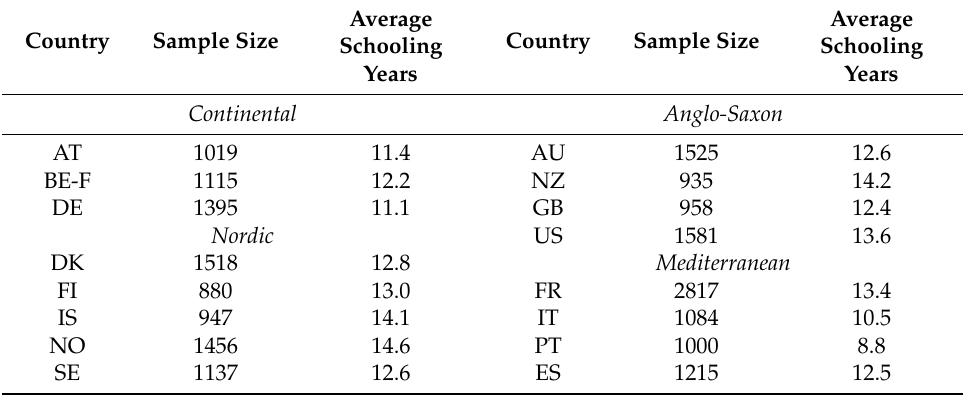
Table 3. Sample sizes of selected countries from ISSP